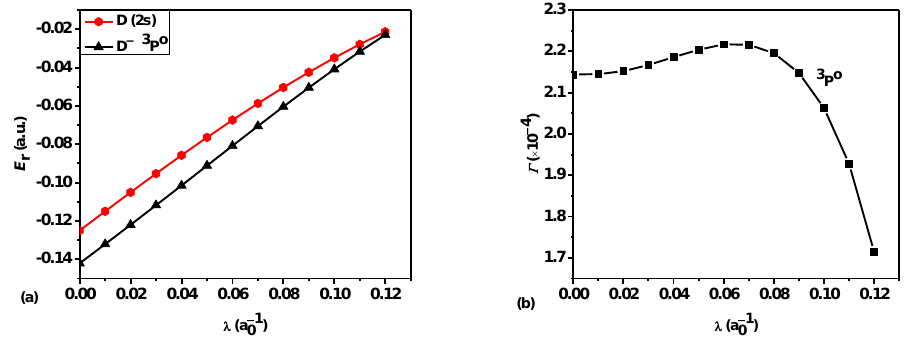
Figure 14. ( a ) Plot of the lowest 3 P o resonance energy 𝐸 𝑟 of D − vs. the screening parameter 𝜆 . ( b ) Plot of the corresponding resonance width 𝛤 of D − vs. the screening parameter 𝜆 .